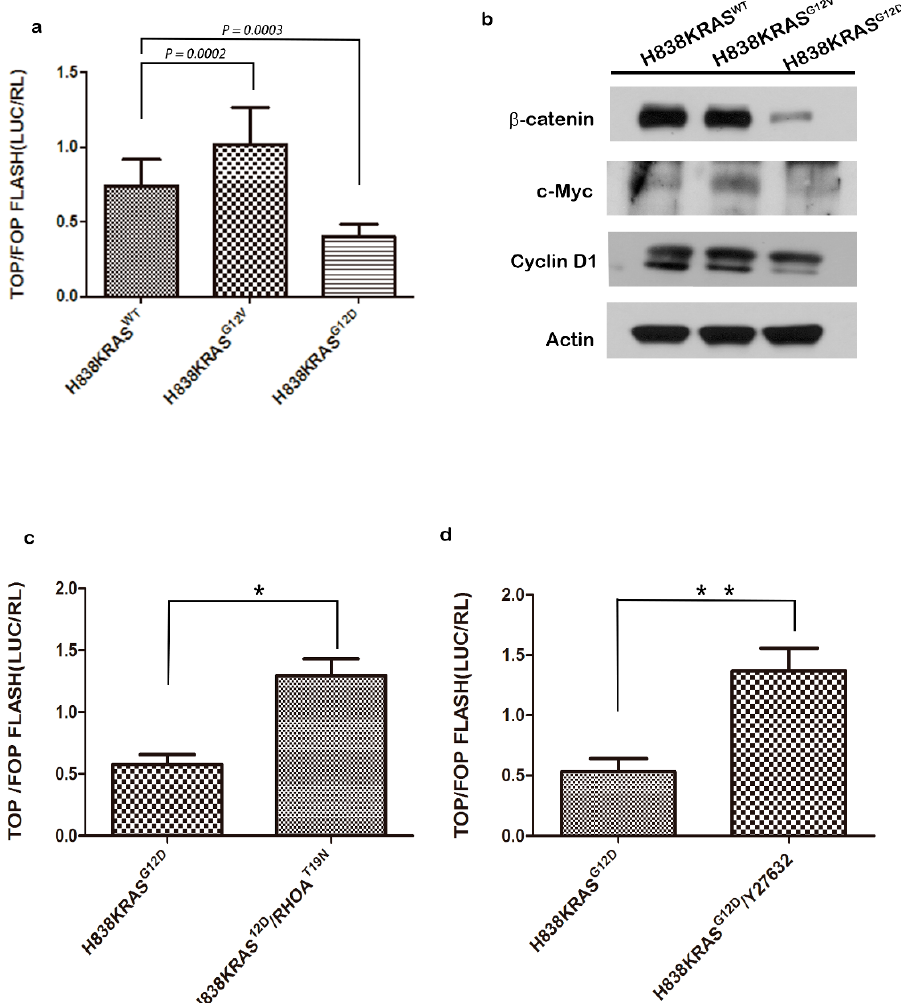
Figure 6. The inactivation of RhoA restores the activity of Wnt / β -catenin pathway. ( a ) The activity of Wnt / β -catenin in H838KRAS isogenic cells as measured by TCF / LEF reporter assays. ( b ) The western blotting of Wnt / β -catenin pathway-related genes. β -actin was used as an internal control. ( c ) The activity of Wnt / β -catenin after inactivation of RhoA by transfecting with RhoA T19N plasmids in H838KRAS G12D cells. ( d ) The activity of Wnt / β -catenin after inactivation of RhoA by treating with Y27632 inhibitor in H838KRAS G12D cells. The activity of Wnt / β -catenin were access by TCF / LEF reporter assays. All reporter activities were evaluated by a dual luciferase system, and the values represent the means ± s.d. of six independent assays ( n = 6, * p < 0.05 and ** p < 0.01). The uncropped blots and molecular weight markers are shown in Figure S10